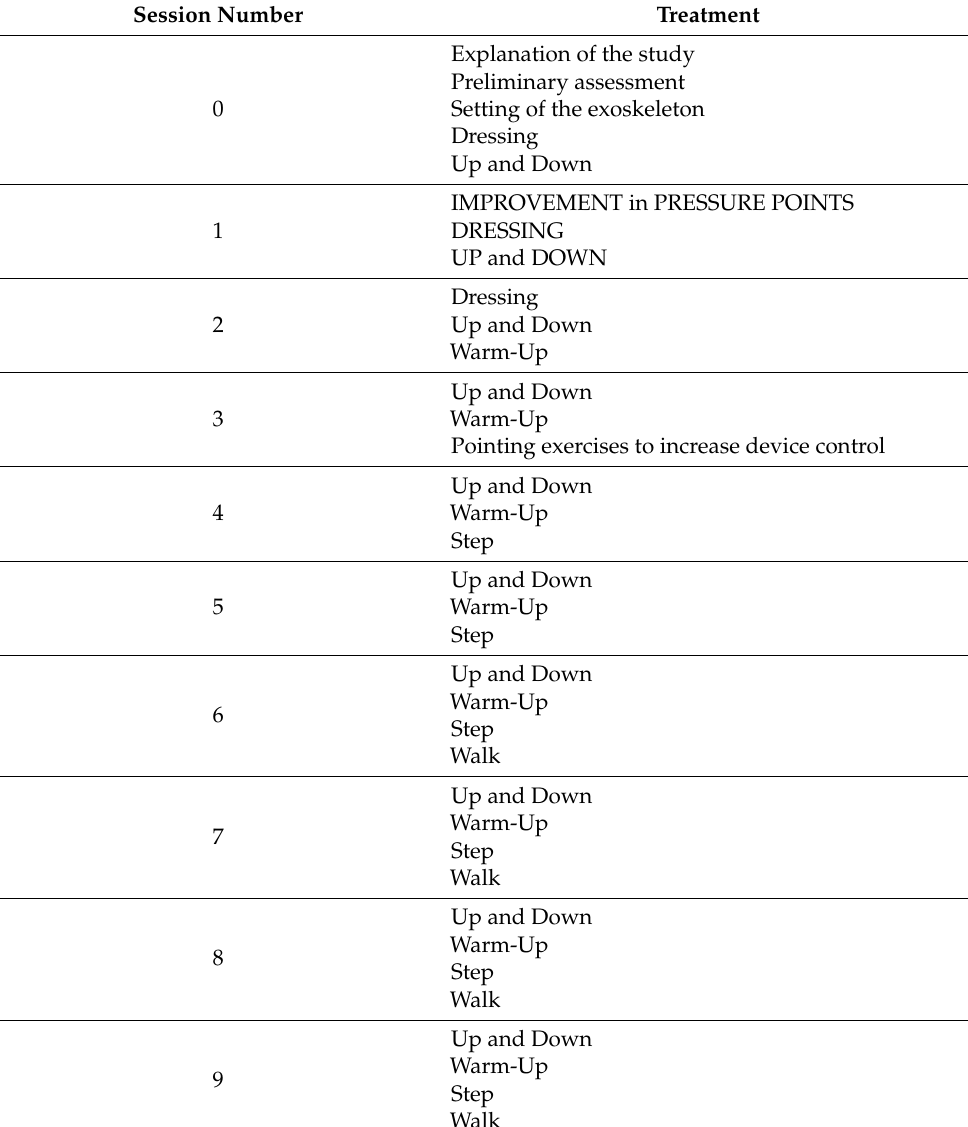
Table 2. Training protocol. Up and down: movement of lifting, and then subsequently of sitting, from a special stool; warm-up: march in place; Step: I walk managing one leg at a time; walk: unlike the step phase, movement is not interrupted between one leg and the